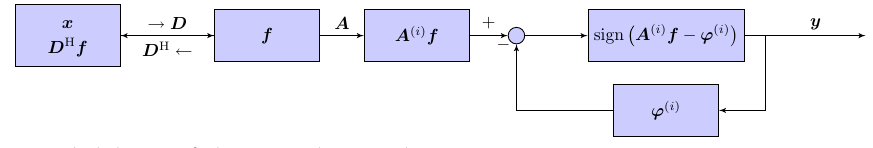
Fig. 1 Block diagram of adaptive sampling